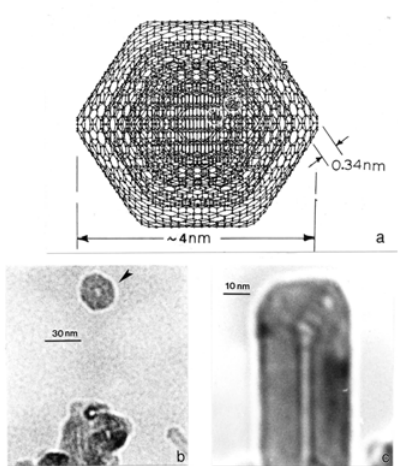
Figure 11: Nanostructural faceting of multiconcentric carbon nanoforms. (a) Schematic rendering of 5-layer carbon fullerene or carbon onion (After [48]). (b) Magnified view of carbon nanoform in fig. 10(d) for comparison with (a). (c) Magnified view of MWCNT end cap facets in fig. 9(a).